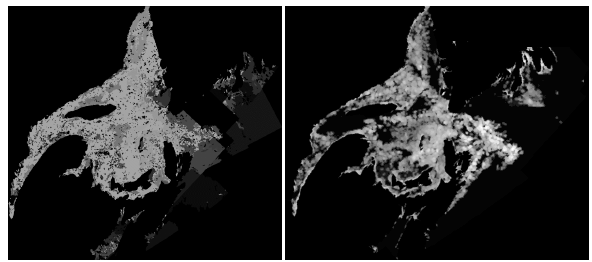
Fig. 8. The texture features used in the ice concentration estimation for March 5, 2009, presented as scaledgray-scaleimages, F e (left)and M g (right).